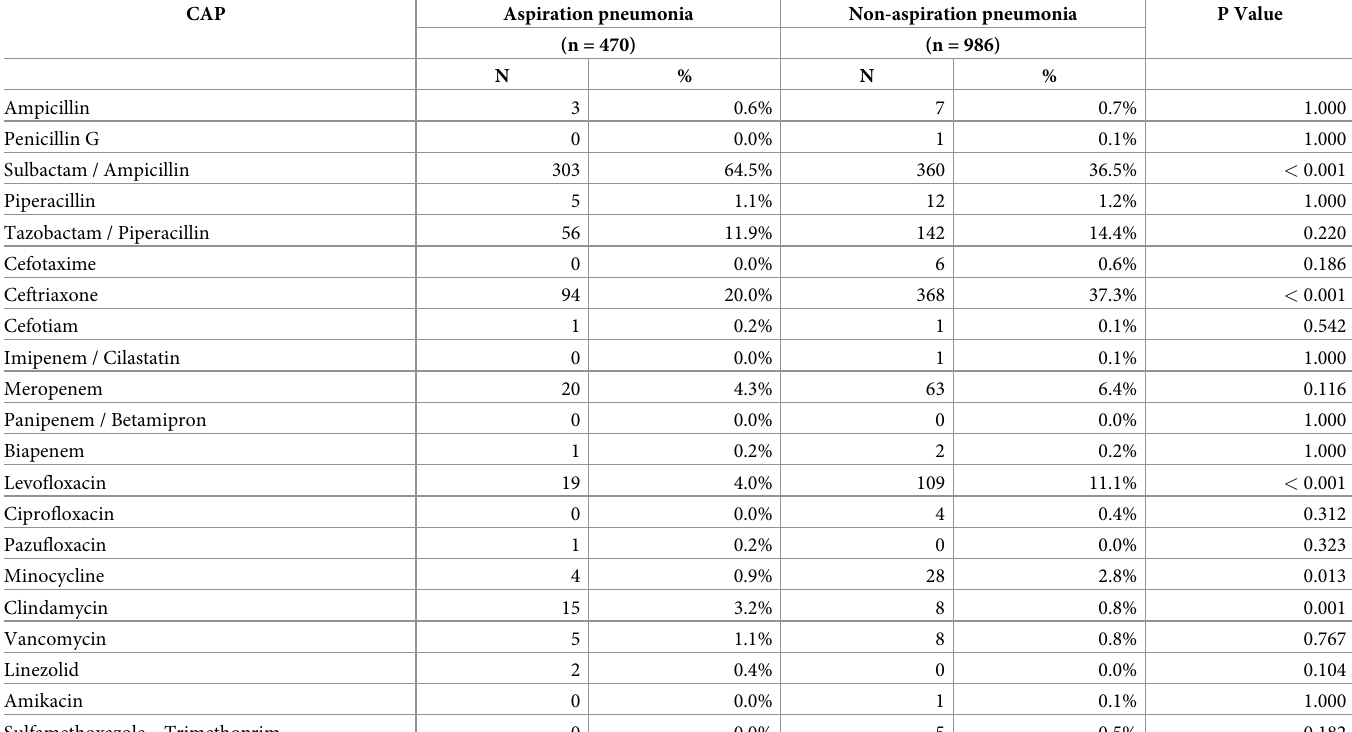
Table 8. Selection of antibiotics in community-acquired pneumonia